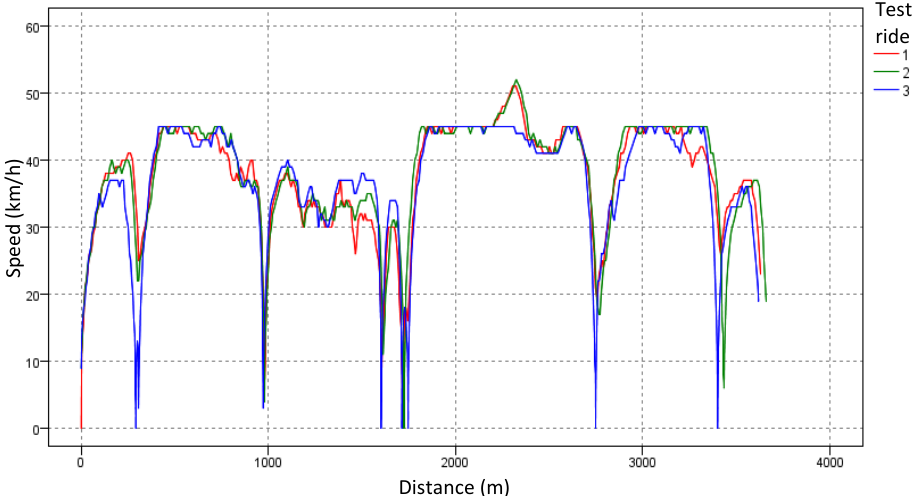
Figure 19. Actual speed profile on the test